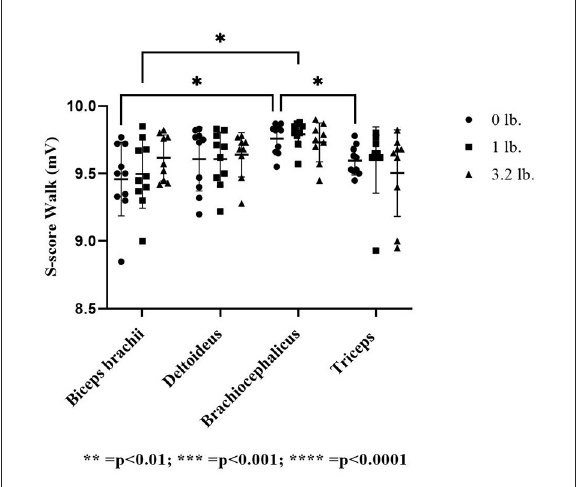
FIGURE4 Acoustic myography (AMG) spatial summation score (S-score) at the walk in the biceps brachii, deltoideus, brachiocephalicus, and triceps ( N = 10). The asterisks denote different levels of significance. The asterisks denote different levels of significance